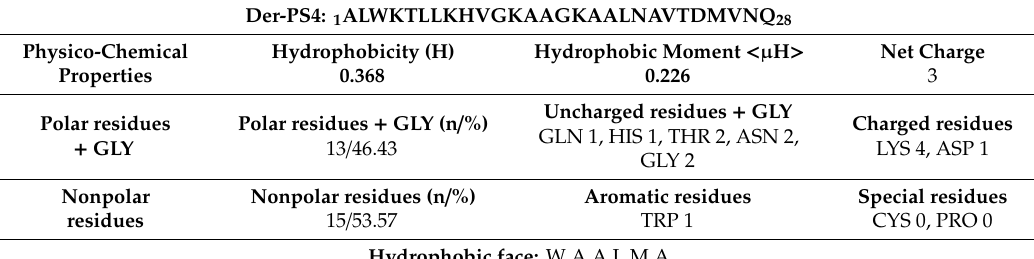
Table 2. MICs and MBCs of Der-PS4, ampicillin and norfloxacin.